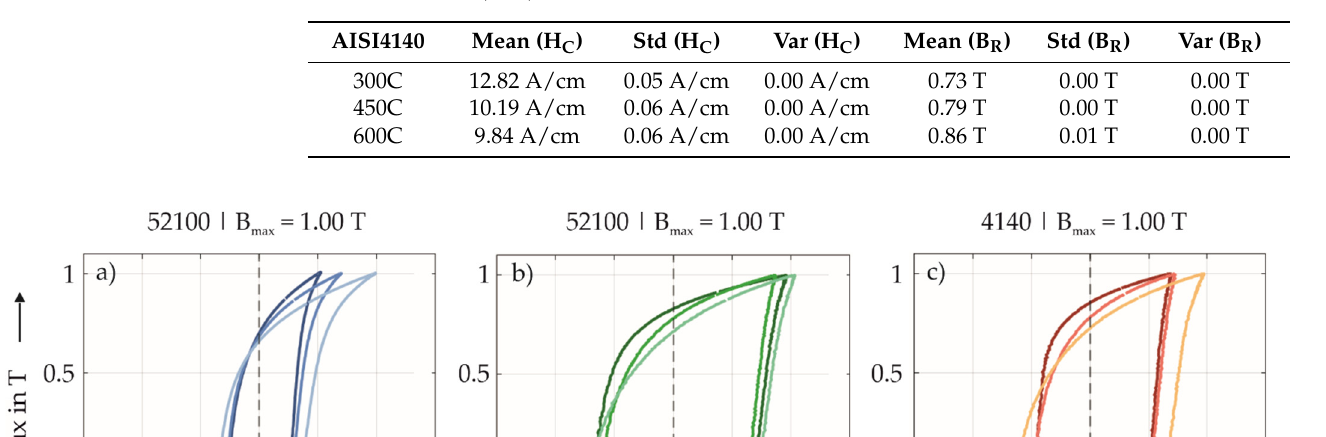
Table 3. Repeatability measurement of magnetic hysteresis on AISI4140 for magnetic coercivity H C and magnetic remanence B R . Calculation of mean value mean ( . . . ), standard deviation std ( . . . ) and variance var ( . . . ) at B max = 1T.